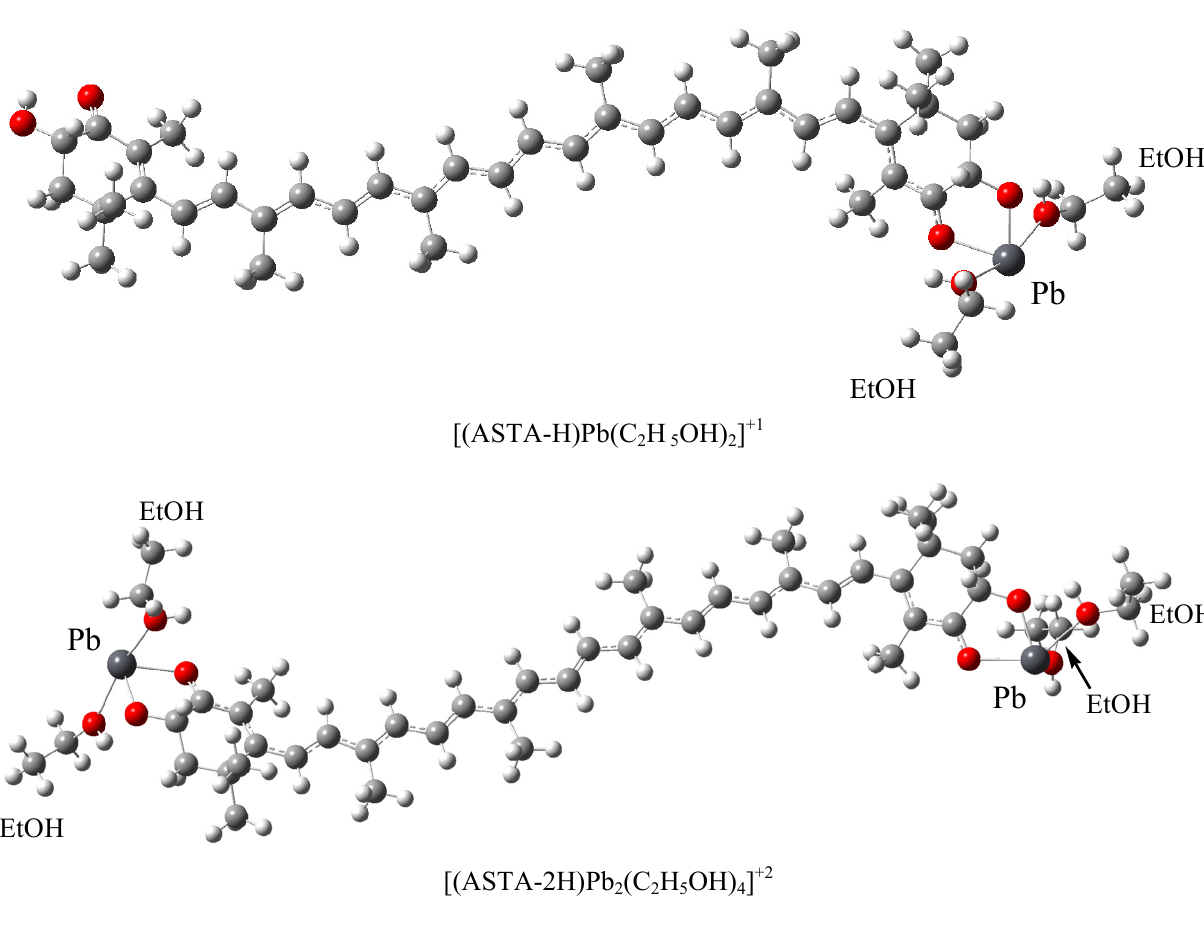
H OH) ] +1 and [(ASTA-2H)Pb 2 5 2